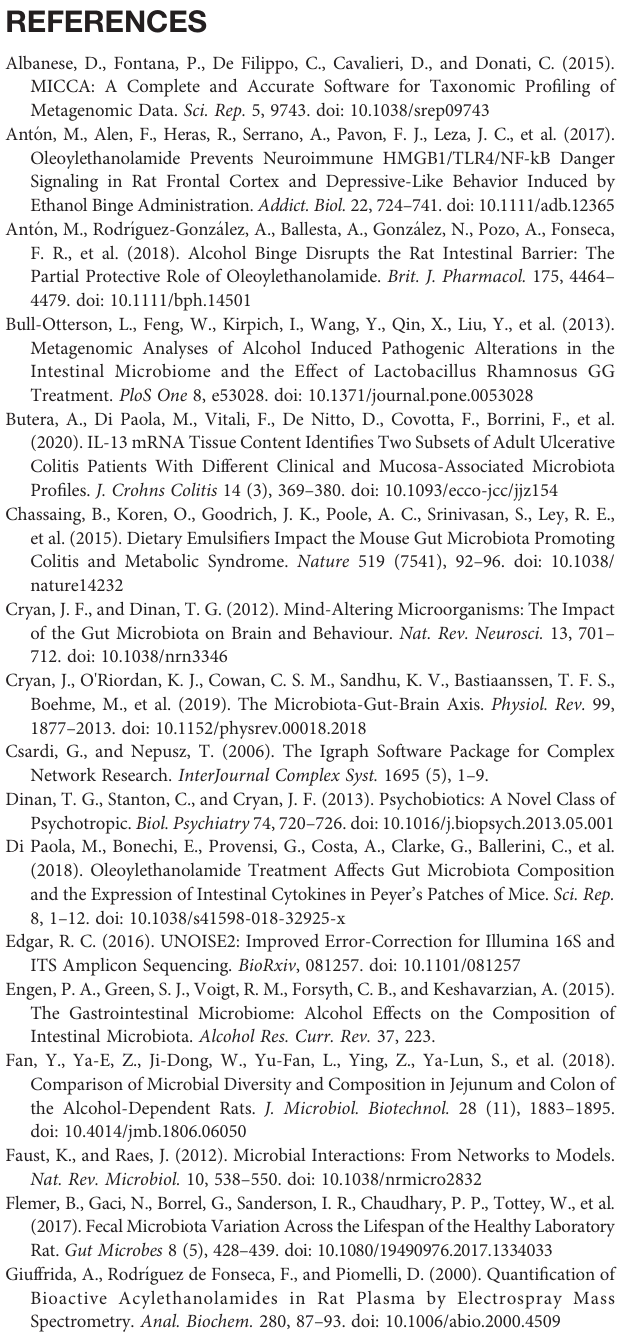
reports frequency distribution of the node degree statistic in the oral OEA network, during the removal of random nodes.Dotted lines represent i) the starting frequency distribution of the “ undisturbed ” oral OEA network (on the right,), ii) the frequency distribution of the i.p. OEA network. Each line represents the frequency distribution of node degree of a different network, re-obtained after removal of one node (and recalculation) of the previous network. The procedure was repeated 20 times. As none of the repetition showed a change in the shape of frequency of node degree distribution from the undisturbed network, we conclude that the loss of speci fi c ASVs from the community led to the observed changes in microbial association network between the oral and the i.p. samples